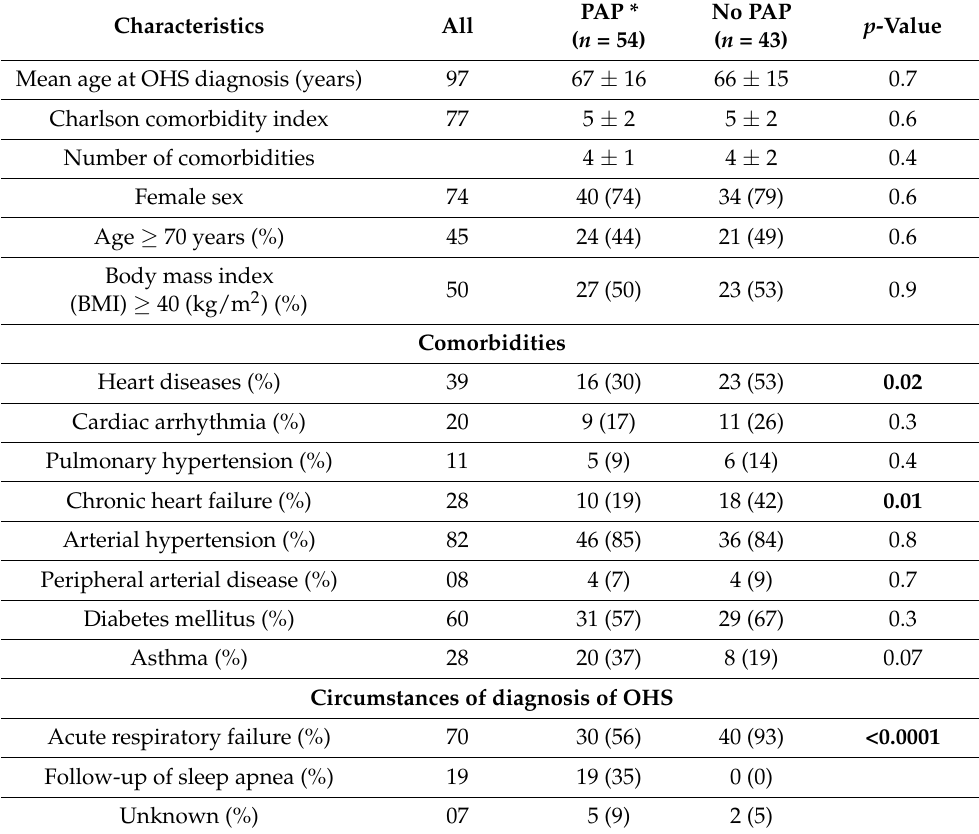
Table 1. Patient characteristics at OHS